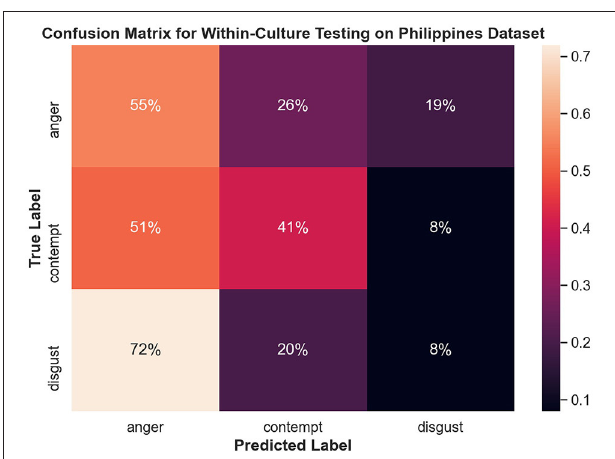
FIGURE 9 | Confusion matrix illustrating the results of the within-culture experiment on the North American data set.